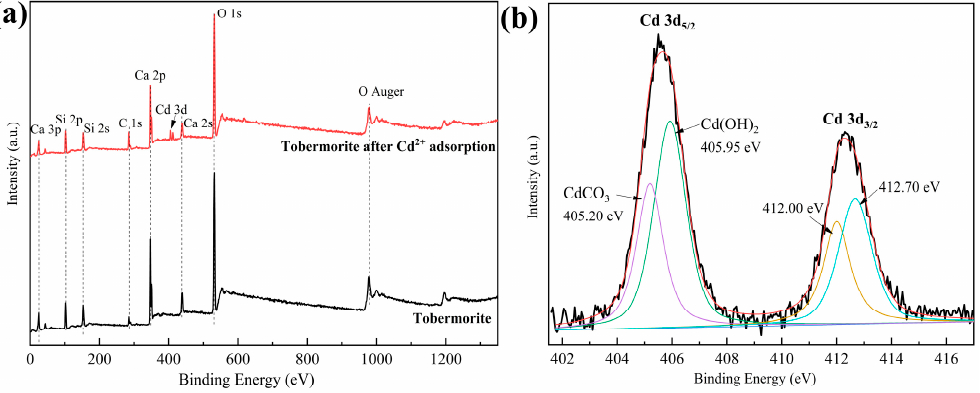
Figure 9. ( a ) XPS survey scans of tobermorite before and after Cd 2+ adsorption; ( b ) high-resolution XPS spectrum of Cd 3d.